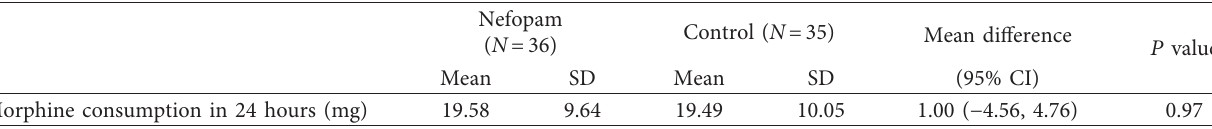
Table 3: Morphine consumption of nefopam and control groups.